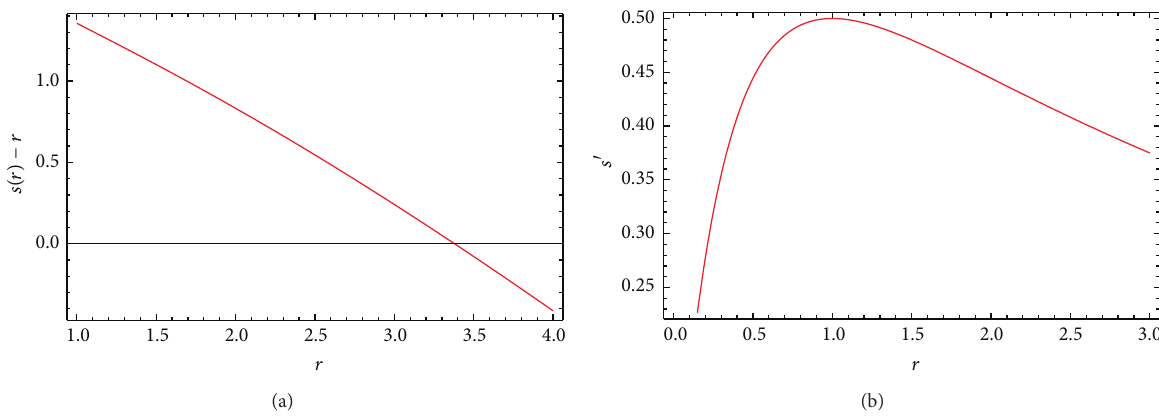
Figure 2: Plots of 𝑠(𝑟) − 𝑟 (a) and 𝑠 󸀠 (b) versus 𝑟 for exponential model.